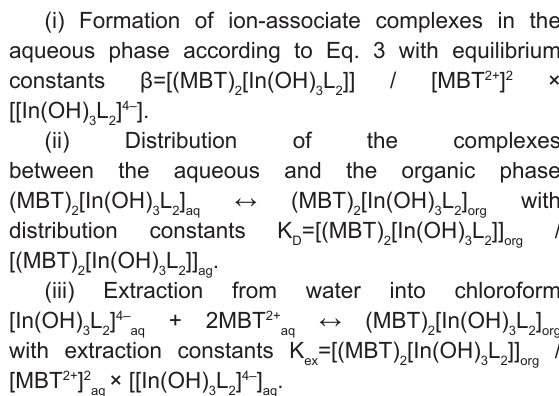
Figure 5. Effect of shaking time on the absorbance. C and 2) and 8.0 (curve 3). InCl 2+ + H L + ↔ [In(HL)] 2+ + Cl – +2H + 3 [In(HL)] 2+ + HL – + 5OH – ↔ [In(OH)